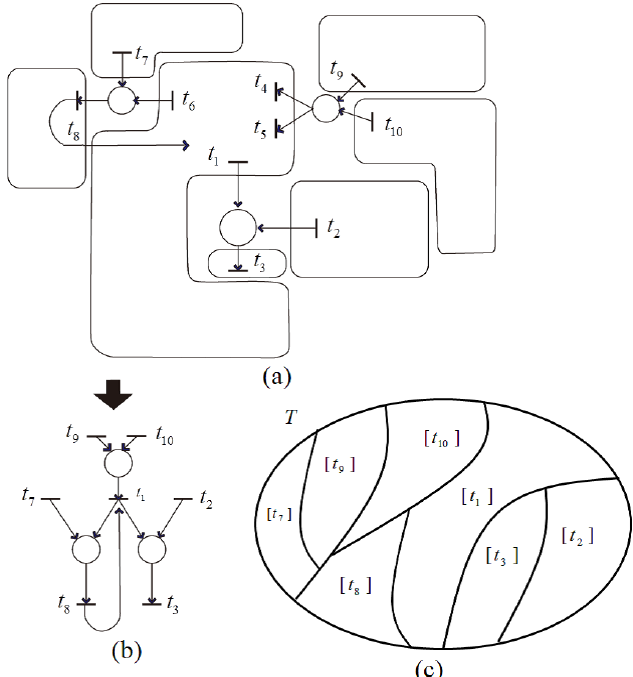
Figure 16. Shrink example of Petri net model and its equivalence classes. ( a ) transitions surrounded by a line satisfies a dependent relation; ( b ) transformed net by applying dependent shrink; ( c ) equivalence classes.